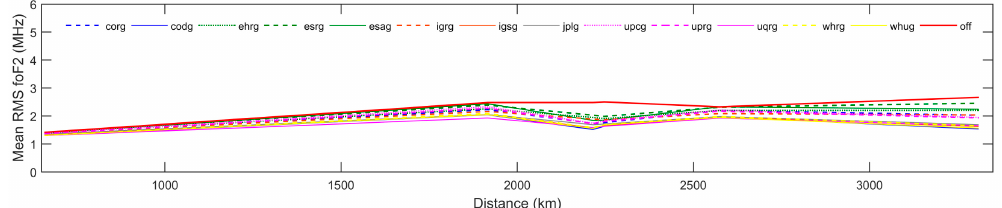
Figure 13. Mean RMS of the differences between fo F 2 values measured at the ionosondes and estimated using GIMs versus the distance of the ionosondes pairs considering one-year data (2015).